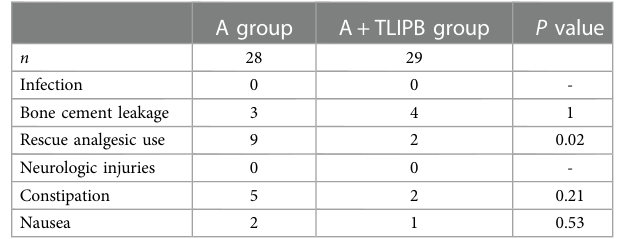
TABLE 2 The complications between the two